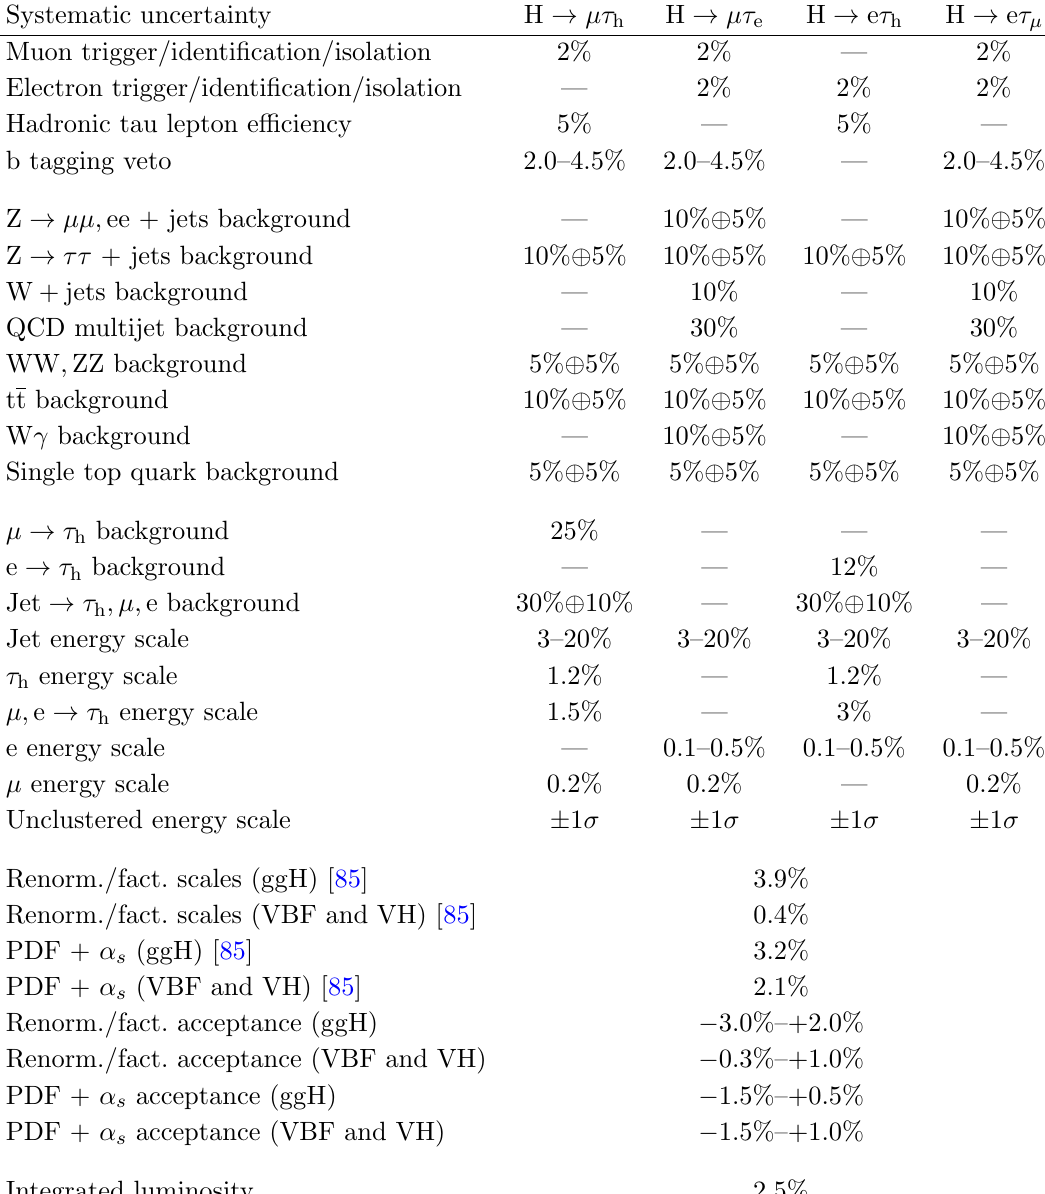
Table 3 . Systematic uncertainties in the expected event yields. All uncertainties are treated as correlated between the categories, except those that have two values separated by the (cid:8) sign. In this case, the (cid:12)rst value is the correlated uncertainty and the second value is the uncorrelated uncertainty for each individual category. Theoretical uncertainties on VBF Higgs boson production [85] are also applied to VH production. Uncertainties on acceptance lead to migration of events between the categories, and can be correlated or anticorrelated between categories. Ranges of uncertainties for the Higgs boson production indicate the variation in size, from negative (anticorrelated) to positive